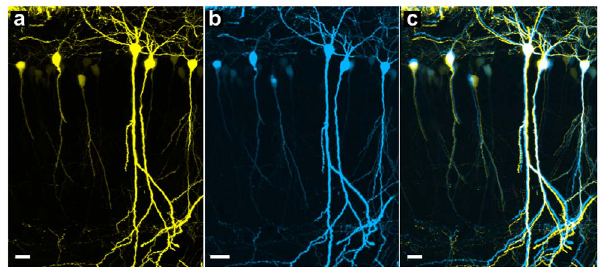
Figure 2. Morphology of pyramidal neurons (hippocampus) is well preserved after being embedded in optimized GMA resin. A brain section from a Thy1-eYFP-H mouse imaged with two-photon microscopy before (a) and after embedding (b). (c) Merged images from (a) and (b). Scale bar, 20 m m. Each image is a max-projection of the image stacks of the brain slice (thickness: 60 m m).